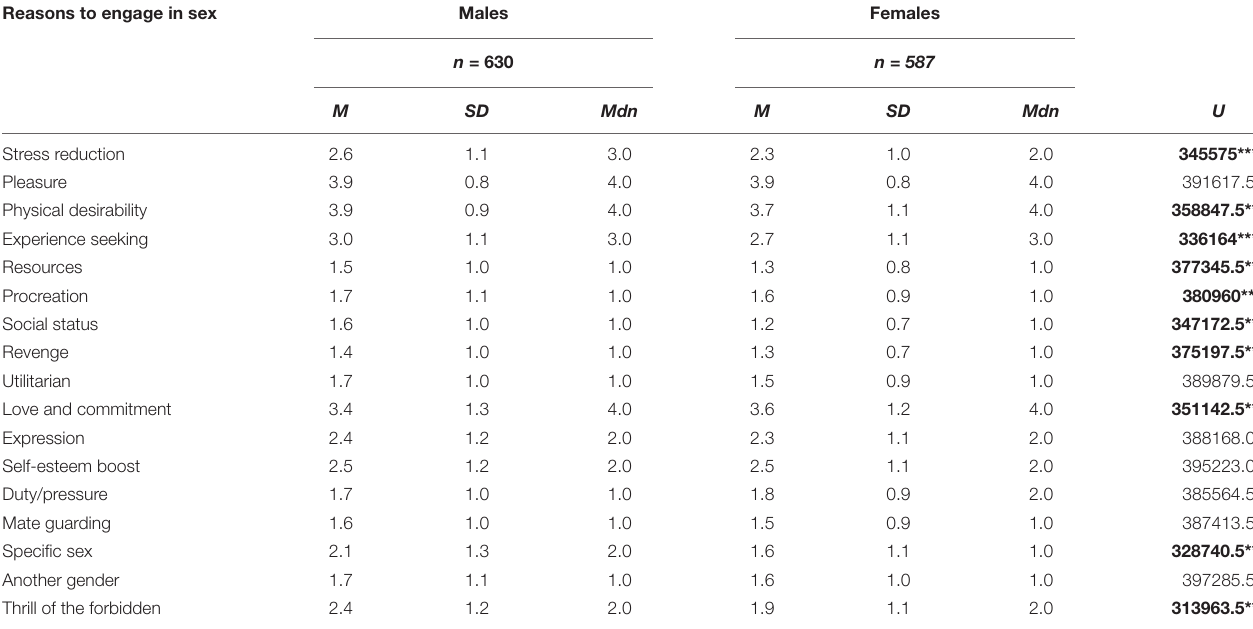
TABLE 2 | Reasons to engage in sex among men and